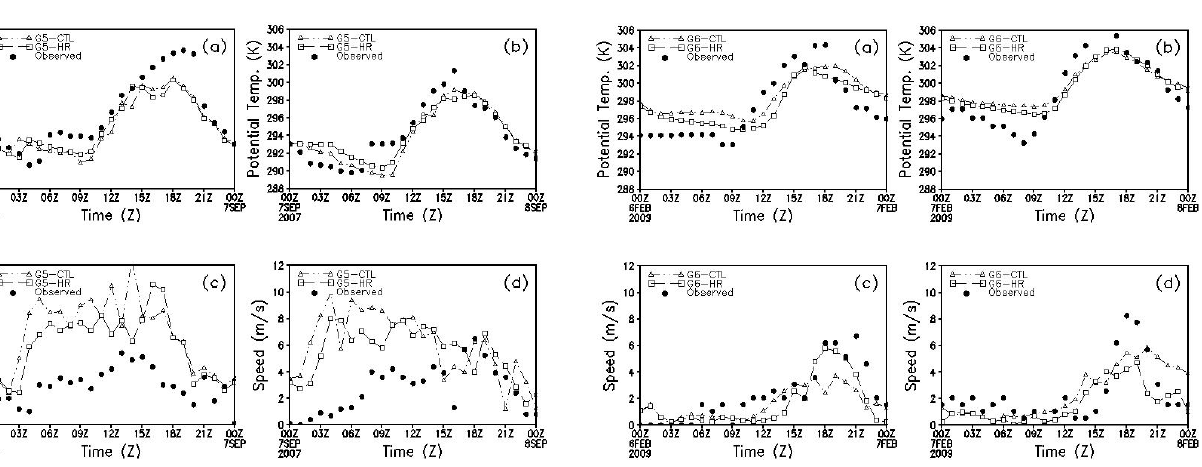
Figure 10. Time cross-section data of (a, b) θ (K), and (c, d) wind speed (ms − 1 ) observed (closed circle) and simulated by G5 of the CTL (open triangle) and HR (open square) runs from 00:00UTC 6 February to 00:00UTC 8 February 2009 at SBAF sur- face weather-observation